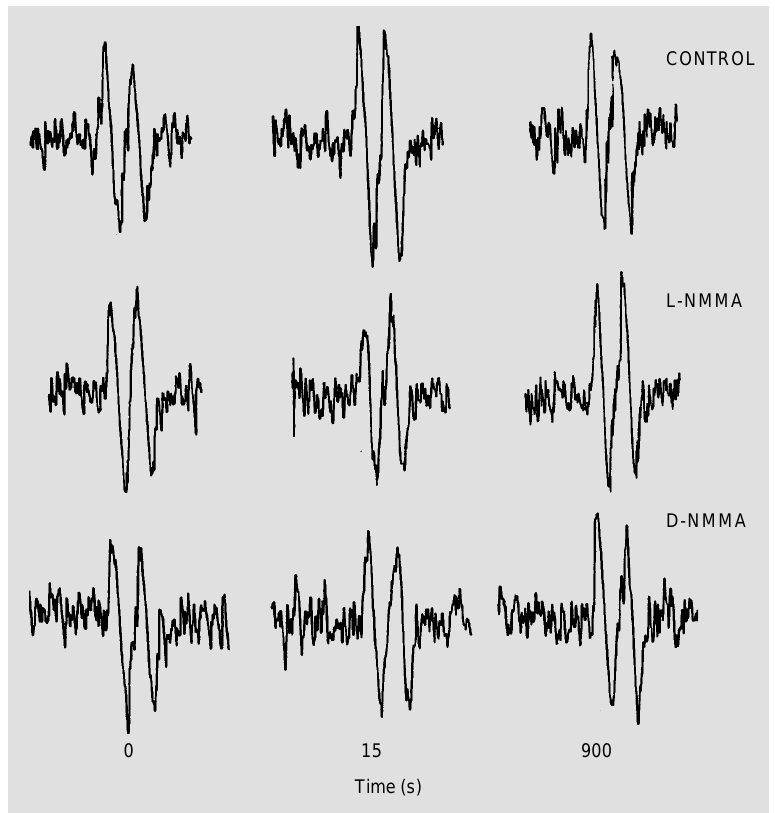
Figure 1 - Characteristic electron paramagnetic resonance spectra of arterial plasma ascor- byl radical (hyperfine splitting constant, a H = 0.186 mT) and its change in response to a flow increase induced by intra-arterial papaverine (2 mg) in untreated control animals. The increase in ascorbyl signals was completely abolished in rabbits treated with L-NMMA and D-NMMA. Peak flow increases occurred at 15 s and returned to baseline levels by 120 s after papaverine injection. Data acquisition parameters were as follows: potency, 20 mW; frequency, 9.7 GHz; modulation amplitude, 0.1 mT; sweeping velocity 0.01 mT/s; time constant,